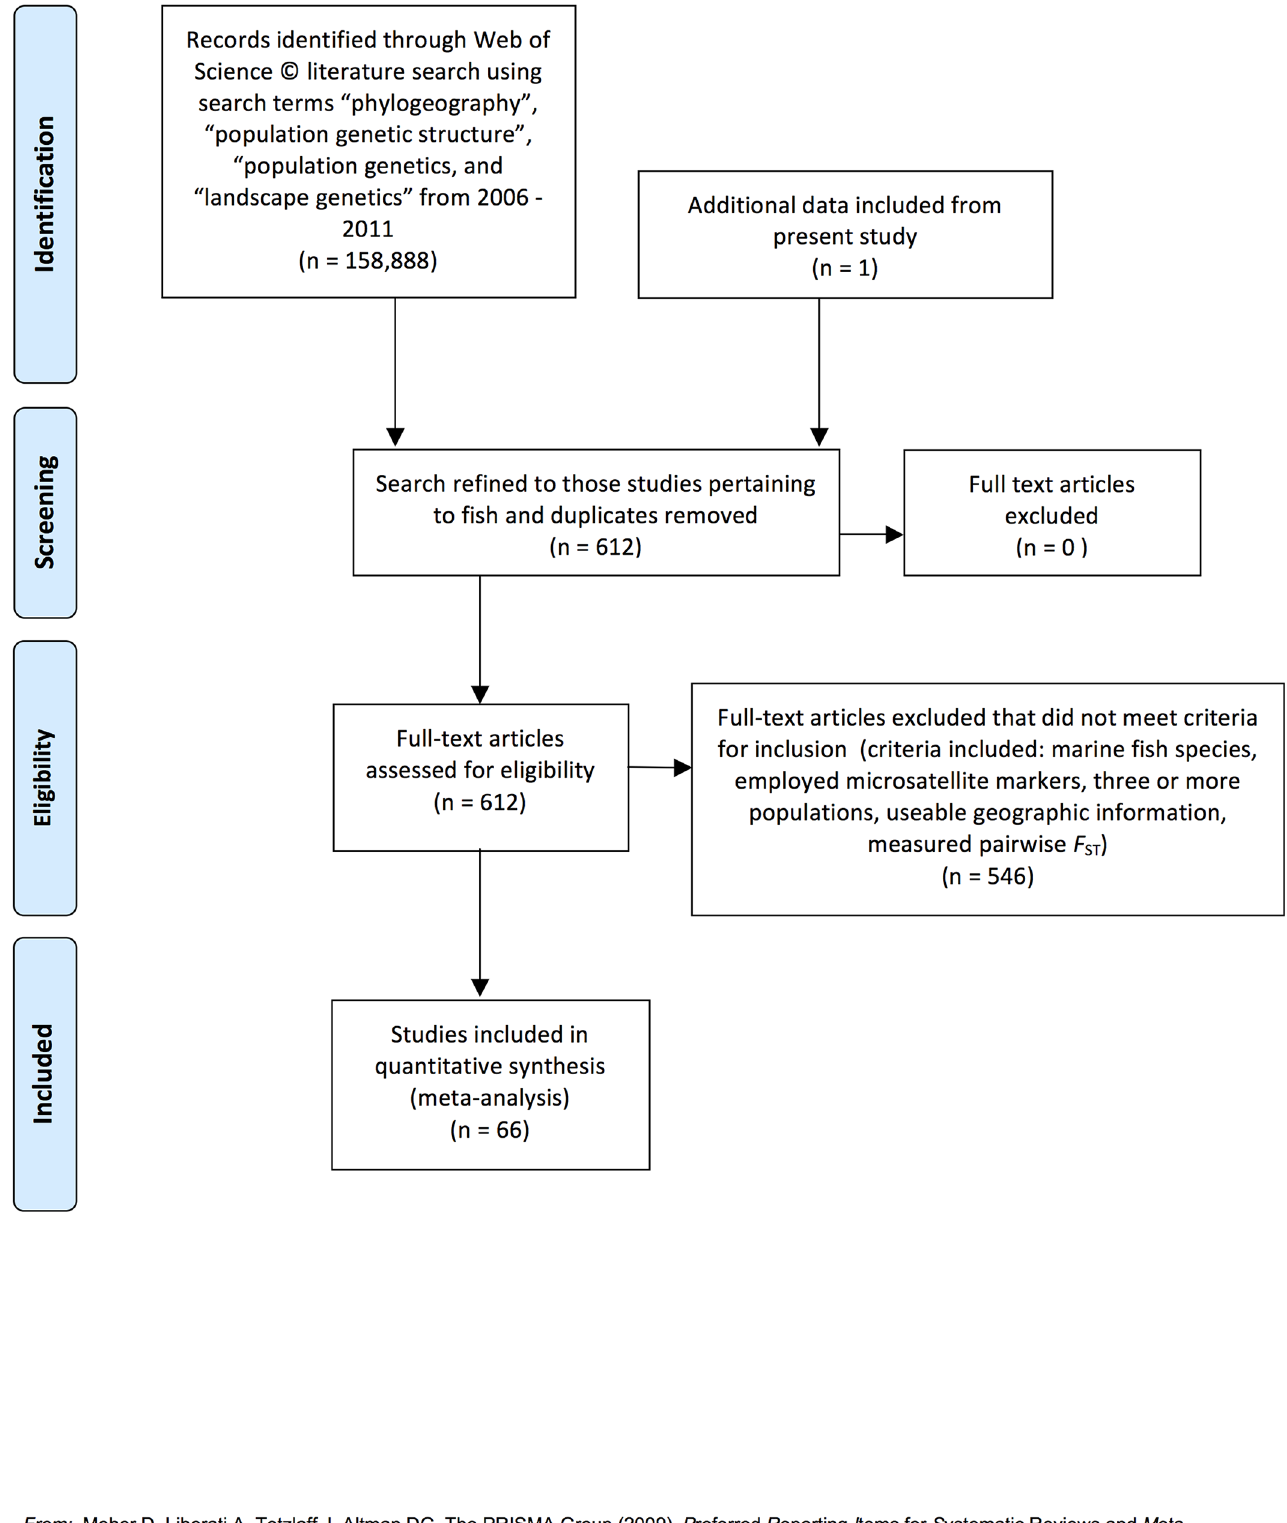
Fig 1. PRISMA 2009 Flow diagram. Depicts the selection process of studies included in the meta-analysis.